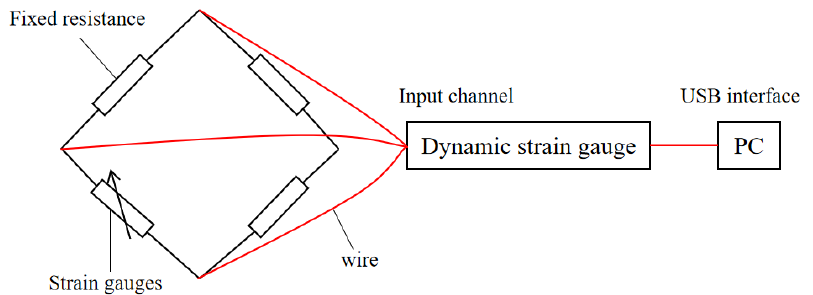
Figure 4. Schematic diagram of strain–flow